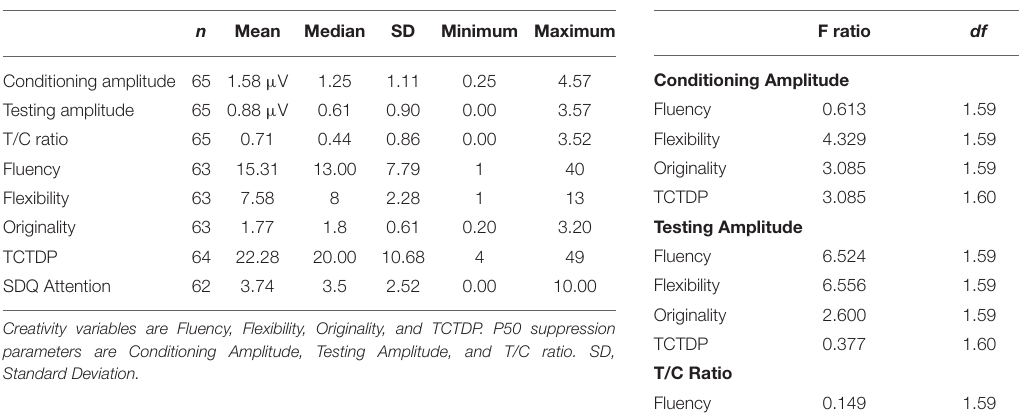
TABLE 1 | Descriptive statistics of P50 suppression parameters, creativity and SDQ attention scale.